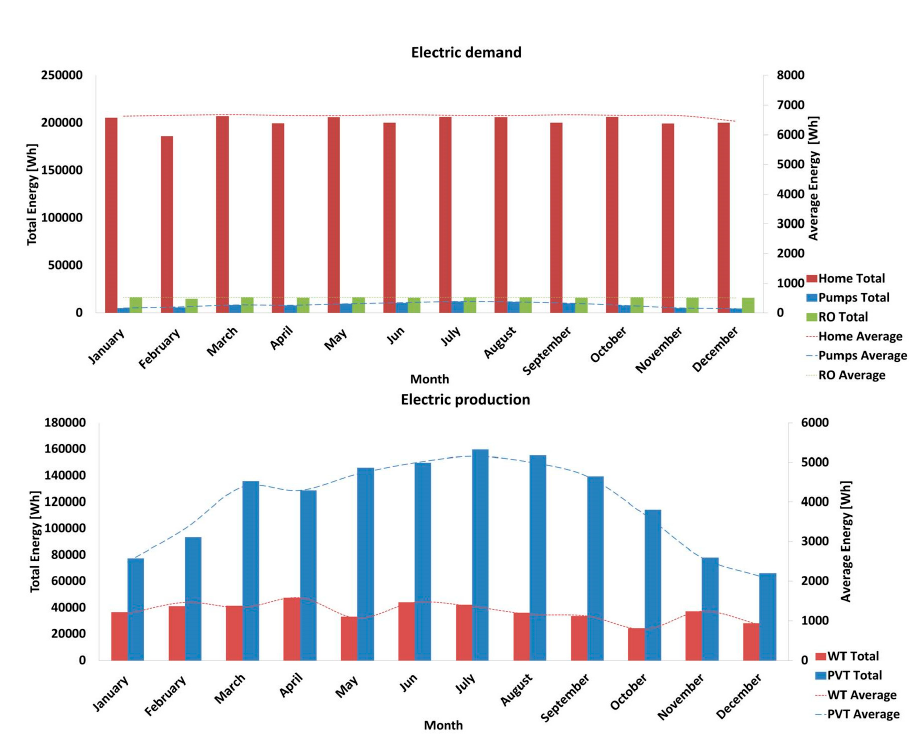
Figure 10. Electric demand and generated power (WT, PVTs).